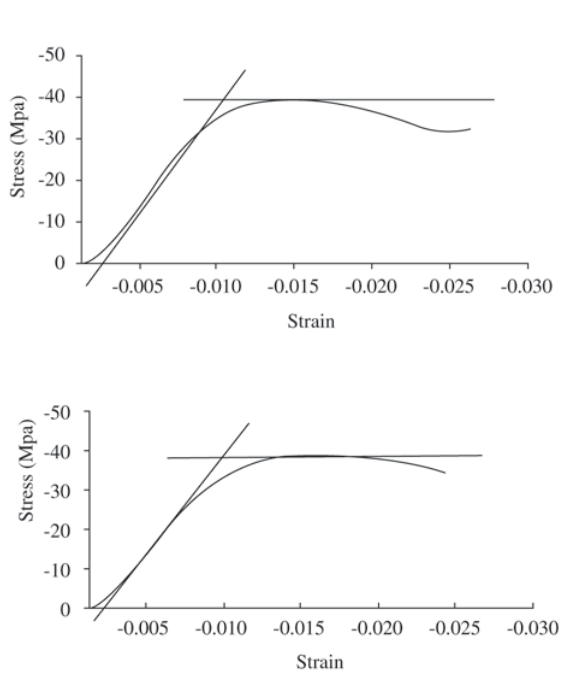
Figure 8. Stress vs . strain in compression parallel to the